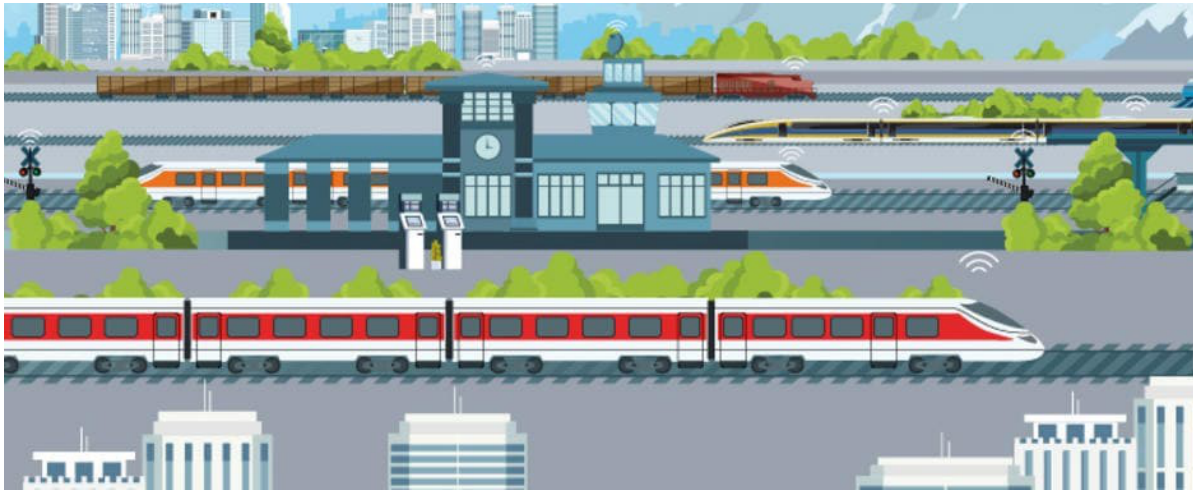
Figure 1. Railways 4.0 with 5G